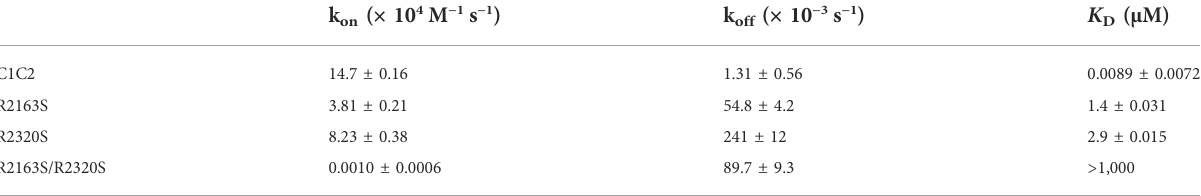
TABLE 1 Apparent binding kinetics and af fi nities of fVIII C1C2 mutations with lipid nanodiscs.